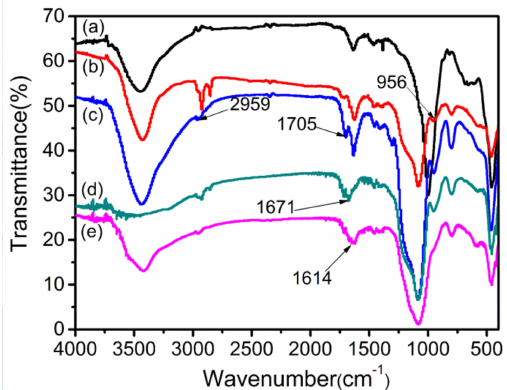
Figure 4. Fourier transform infrared (FTIR) spectra of (a) raw vermiculite (Verm), (b) acid-activated vermiculite (a-Verm), (c) 3-(triethoxysilyl)propyl methacrylate-modified acid vermiculites (OVerm), (d) polyacrylamide (PAM)/OVerm and (e) triethylenetetramine-grafted polyacrylamide